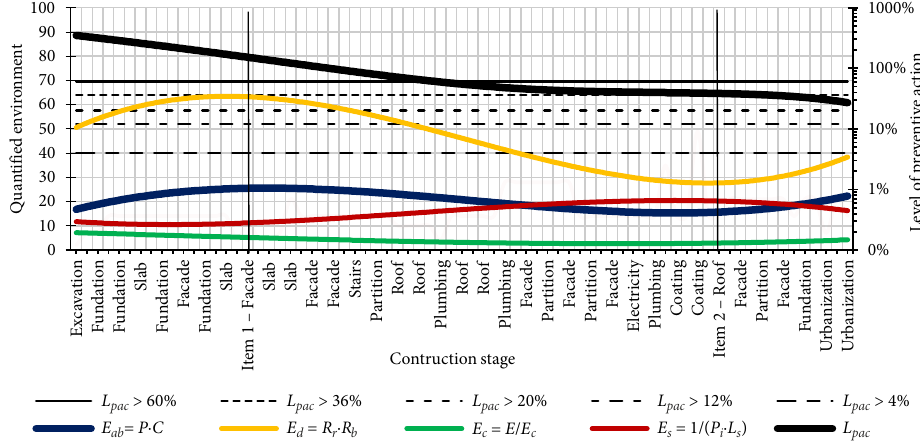
Figure 3. Preventive action environments regarding the risk of worker falls at different levels